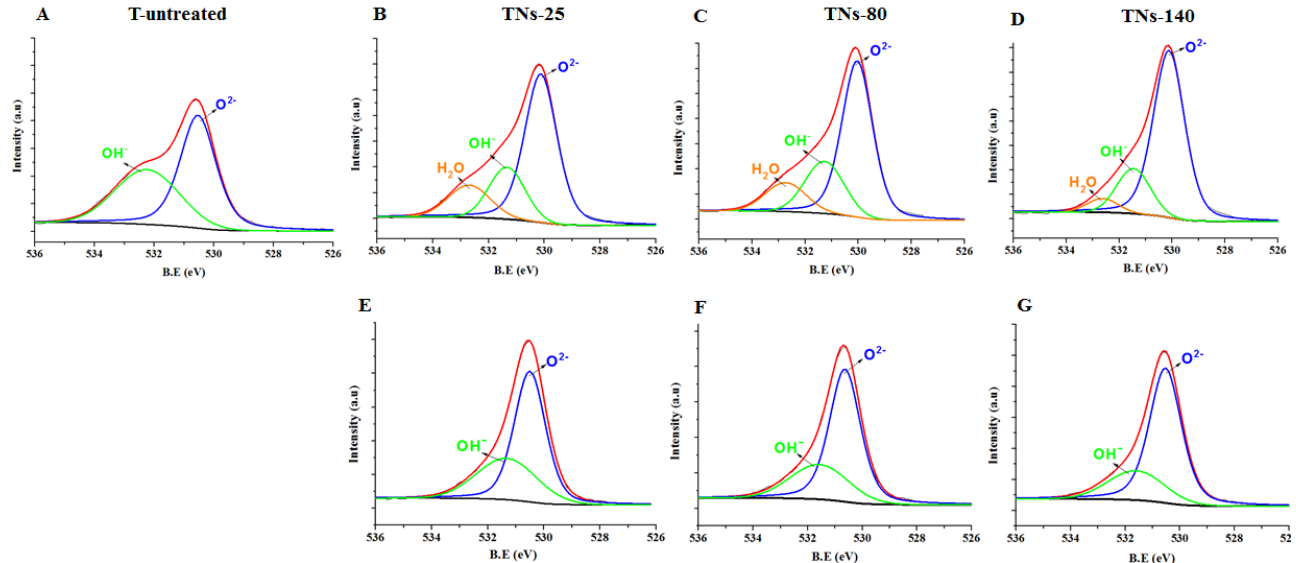
Figure 3. High-resolution XPS spectra of O 1s for ( A ) T-untreated, ( B , E ) TNs-25, ( C , F ) TNs-80, and ( D , G ) TNs-140 surfaces ( A – D ) prior to and ( E – G ) after Ar + sputtering.